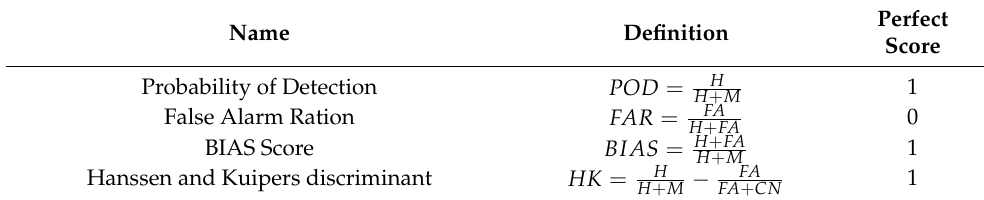
Table 1. Parameters for the dichotomous statistics.